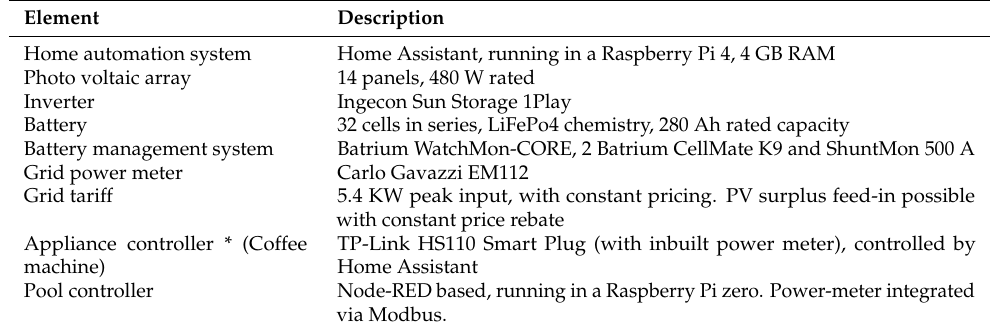
Table 4. Test-bed summary.